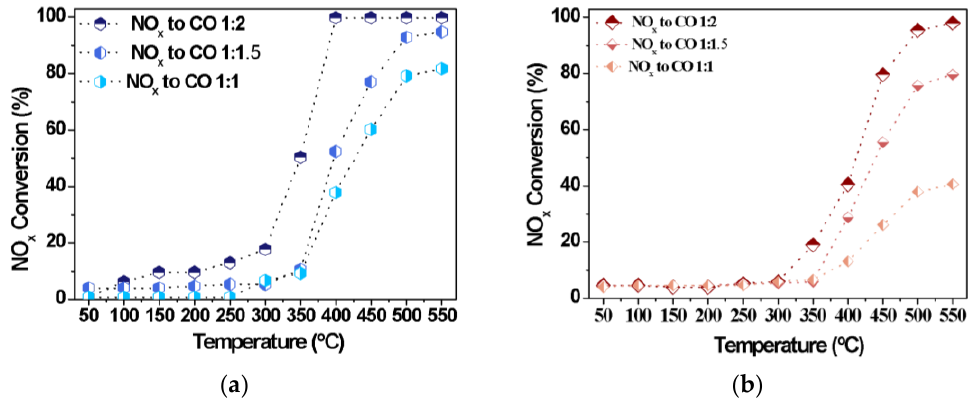
Figure 7. NO x conversions as a function of the temperature for distinct NO x to CO molar ratios over ( a ) Cu 8 /SBA-15 and ( b ) Fe 10 /SBA-15 samples.